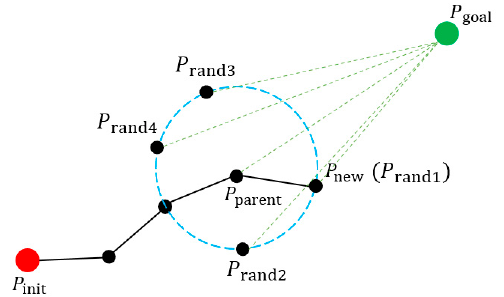
Figure 2. Random tree expansion diagram of the improved algorithm based on the PPD strategy. The red circle indicates the starting point, and the green circle indicates the target point. The black circle indicates the path point, the solid black line indicates the path. and the green dashed line indicates the distance from the point to the target point. The blue dashed line indicates the circumference of the circle with the parent point as the center and the step length ρ as the radius, which is the random sampling space. P rand 1 ~ P rand 4 denote random sampling points, P parent denotes parent point, and P new denotes the new